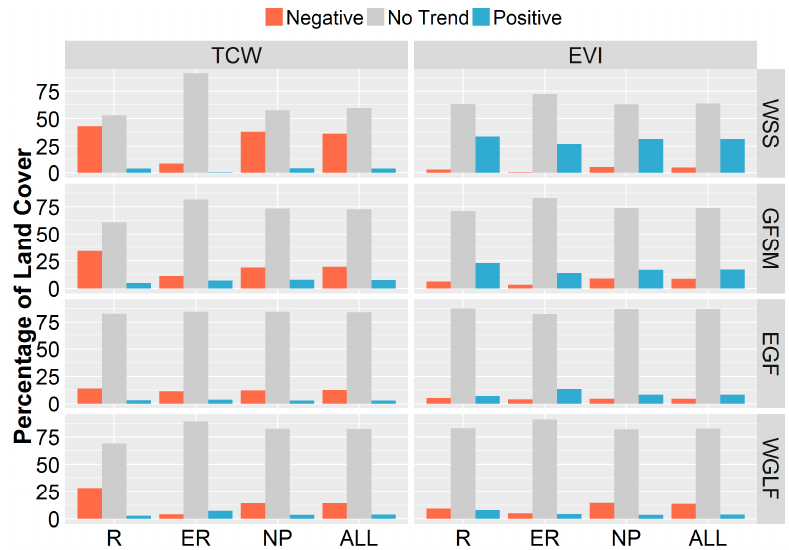
Figure 5. Summary of trend analysis results for different levels of protection status, stratified by WWF terrestrial ecoregions. Abbreviations are: R: reserve; ER: eco-reserve; NP: non-protected; ALL: ALL = R + ER + NP; WSS: West Sudanian Savanna; GFSM: Guinean Forest-Savanna Mosaic; EGF: Eastern Guinean Forest; WGLF: Western Guinean Lowland Forests.